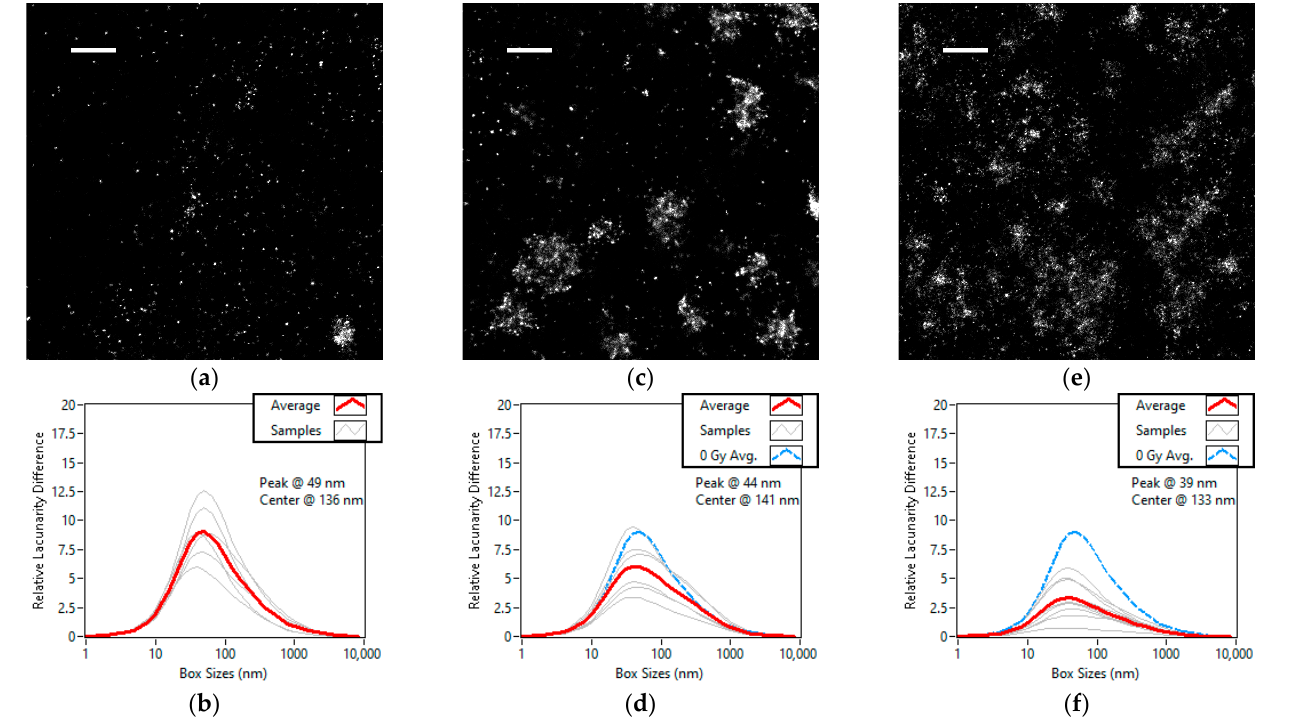
Figure 5. Super-resolution images and lacunarity difference curves of Alexa Fluor 647 labelled γ H2AX in the nuclei of U2OS cells grouped by radiation dosage. Each cell was observed 30 min after being subjected to 0 Grays ( a , b ), 2 Grays ( c , d ) and 5 Grays ( e , f ) of ionizing radiation. Scale bars are 1 µm. The number of studied cells is 6, 7 and 9, respectively. On each lacunarity difference curve, the average of the curves for each cell is shown in red and the average of the untreated U2OS is shown in dashed blue.